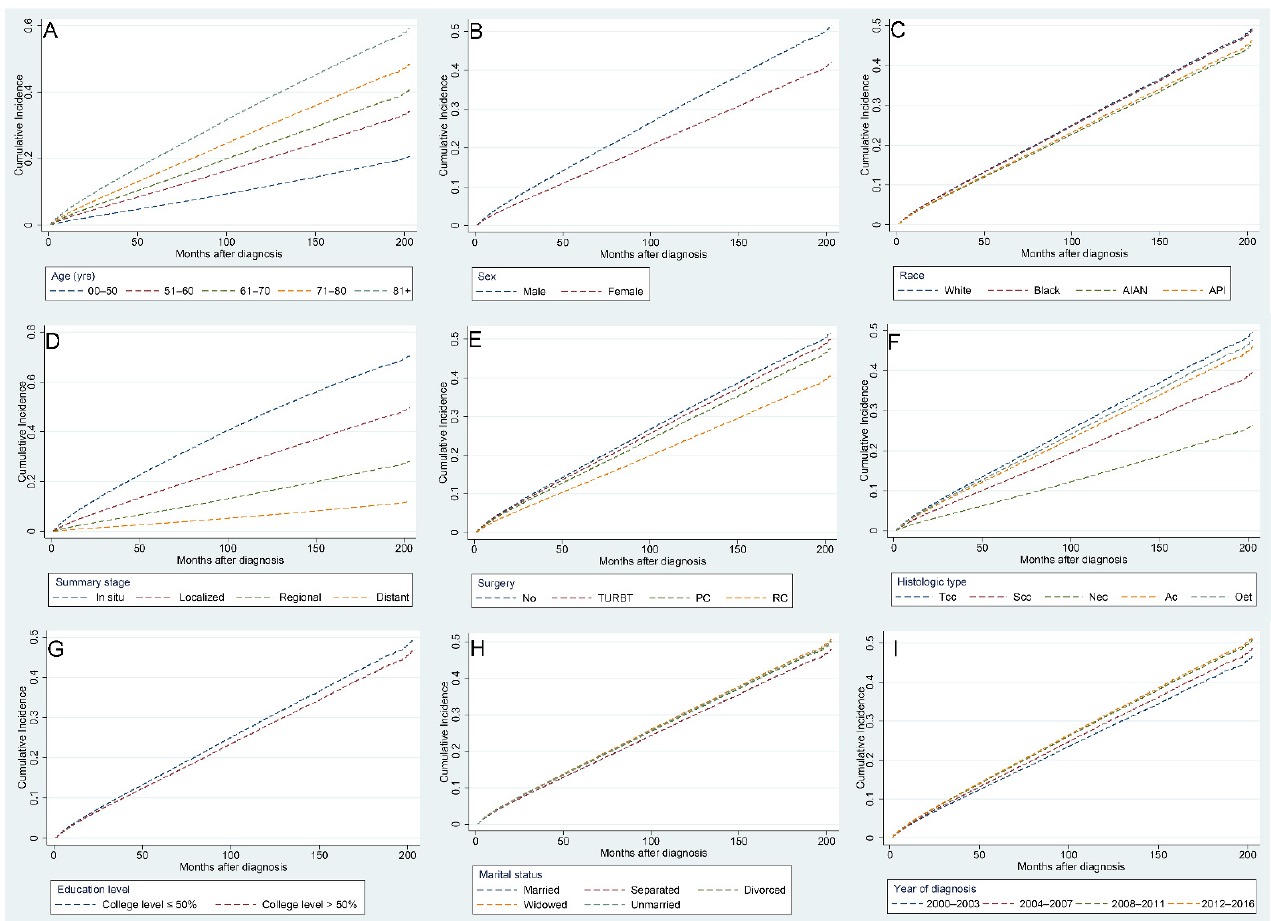
Figure 8. Cumulative incidence curves for various factors of cardiovascular mortality in bladder cancer patients after competing risk regression analysis: age ( A ), sex ( B ), race ( C ), summary stage ( D ), surgery ( E ), histologic type ( F ), education level ( G ), marital status ( H ), and year of diagnosis ( I ).